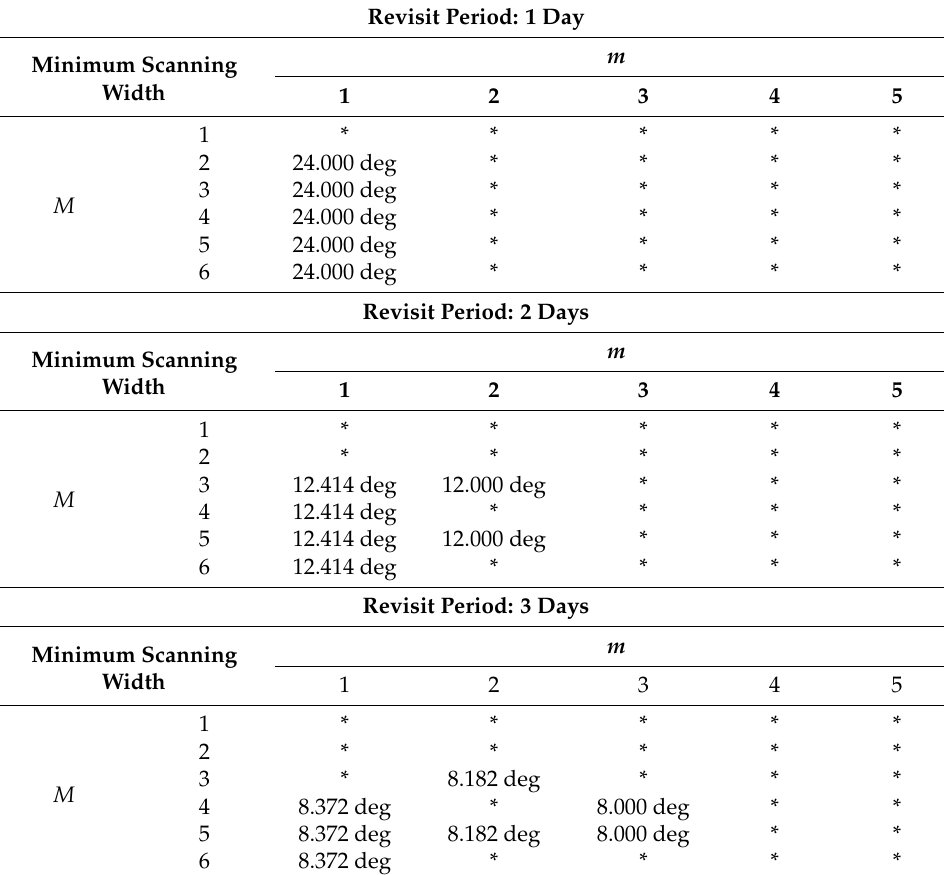
Table 2. Correspondence between the revisit period and the minimum scanning width under different M and m